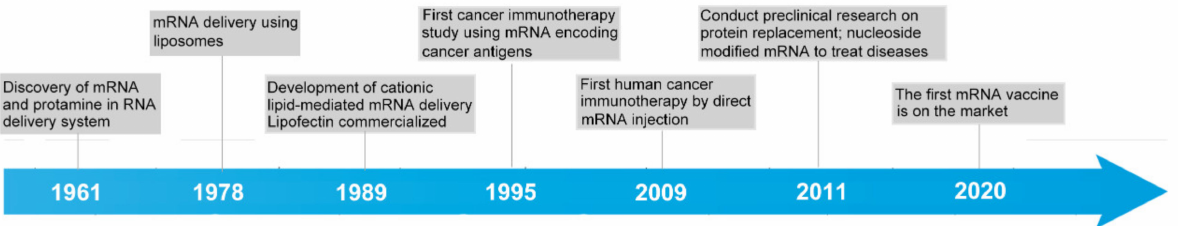
Figure 1. The history of the development of mRNA